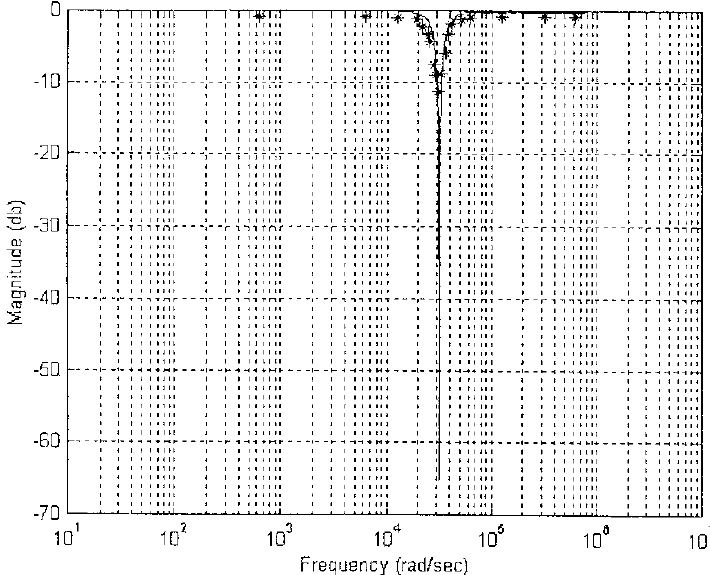
FIGURE 5 Calculated (____) and simulated (**) characteristic of the mixed-mode notch filter (NF) obtained from I out 4 with I in 1 ¼ I in 2 ¼ V in 1 ¼